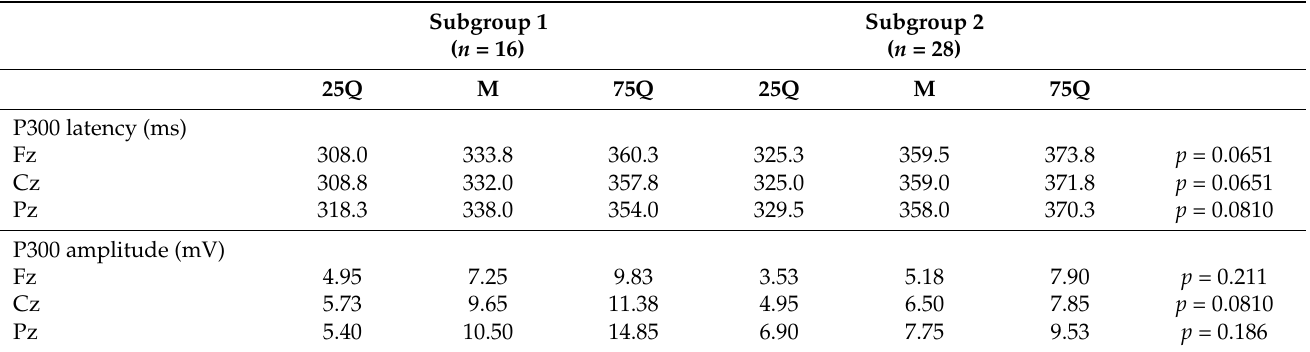
Table 8. Comparison of P300 parameters between the subgroups without (1) and with (2) cognitive